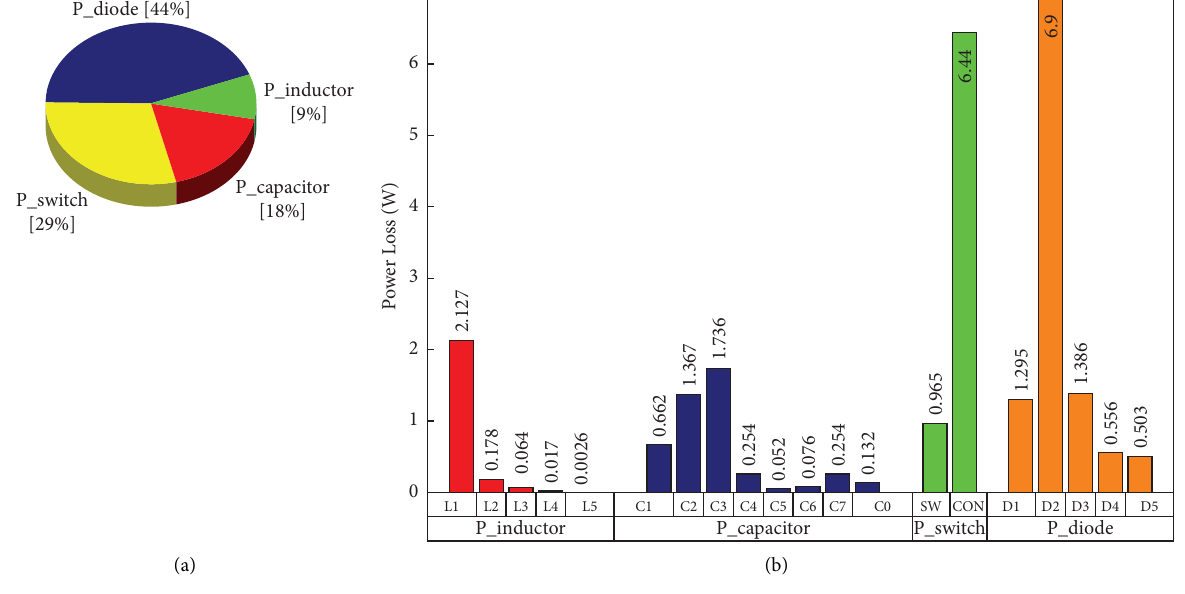
Figure 10: (a) Cumulative losses. (b) Loss breakdown